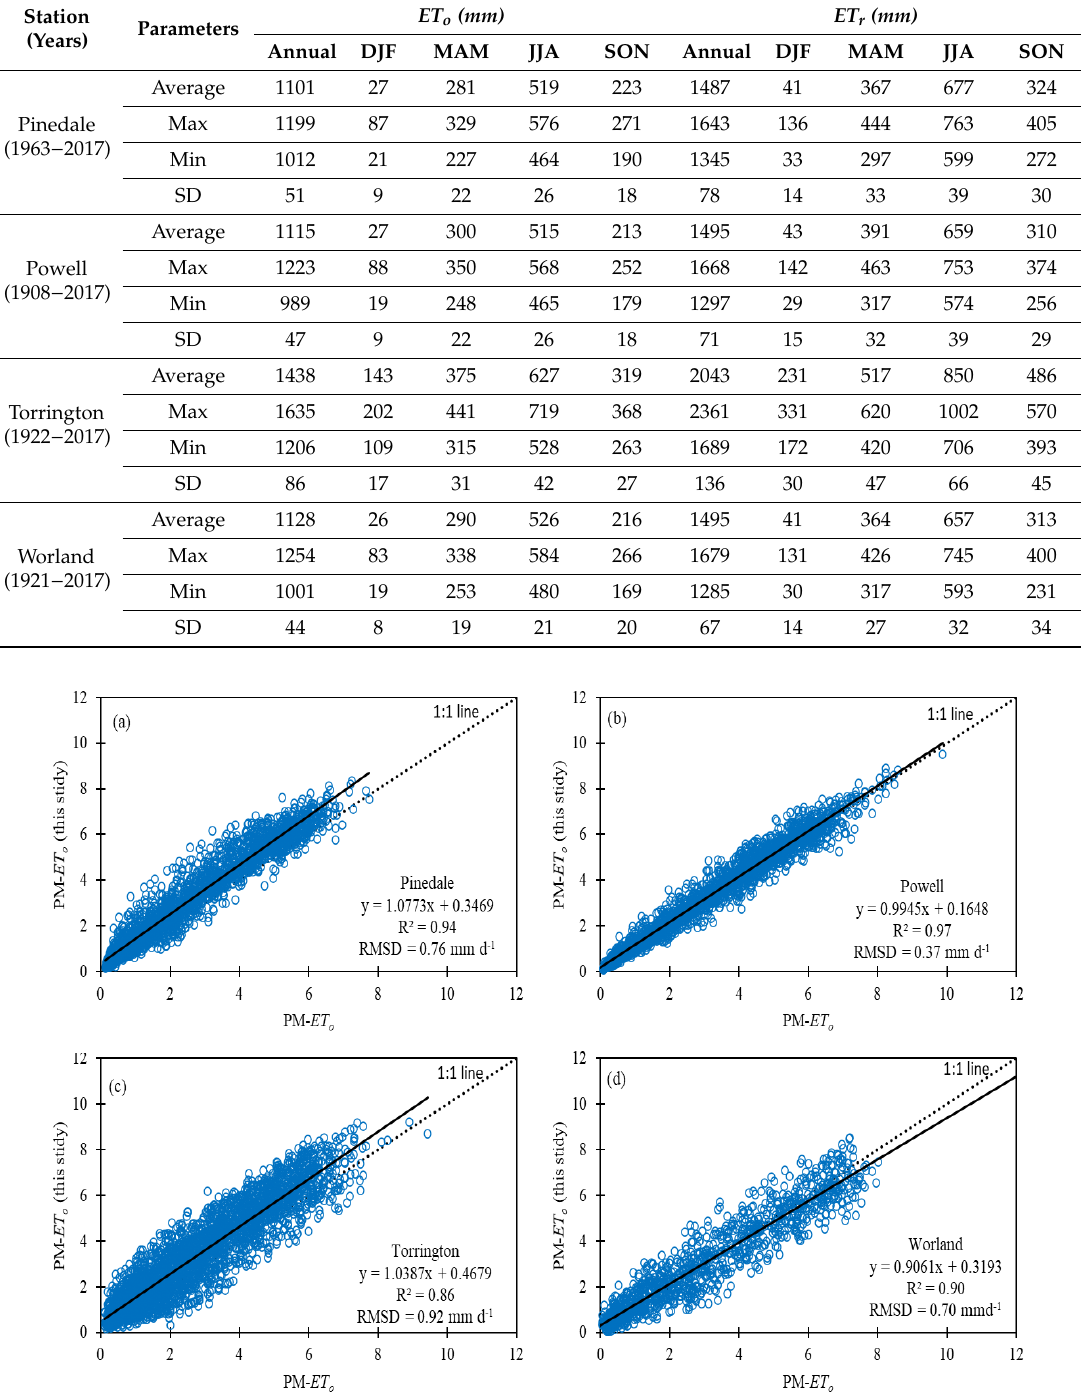
Table 6. Descriptive statistics for annual and seasonal grass and alfalfa reference evapotranspiration ( ET o and ET r , mm) for four weather stations in the state of Wyoming.